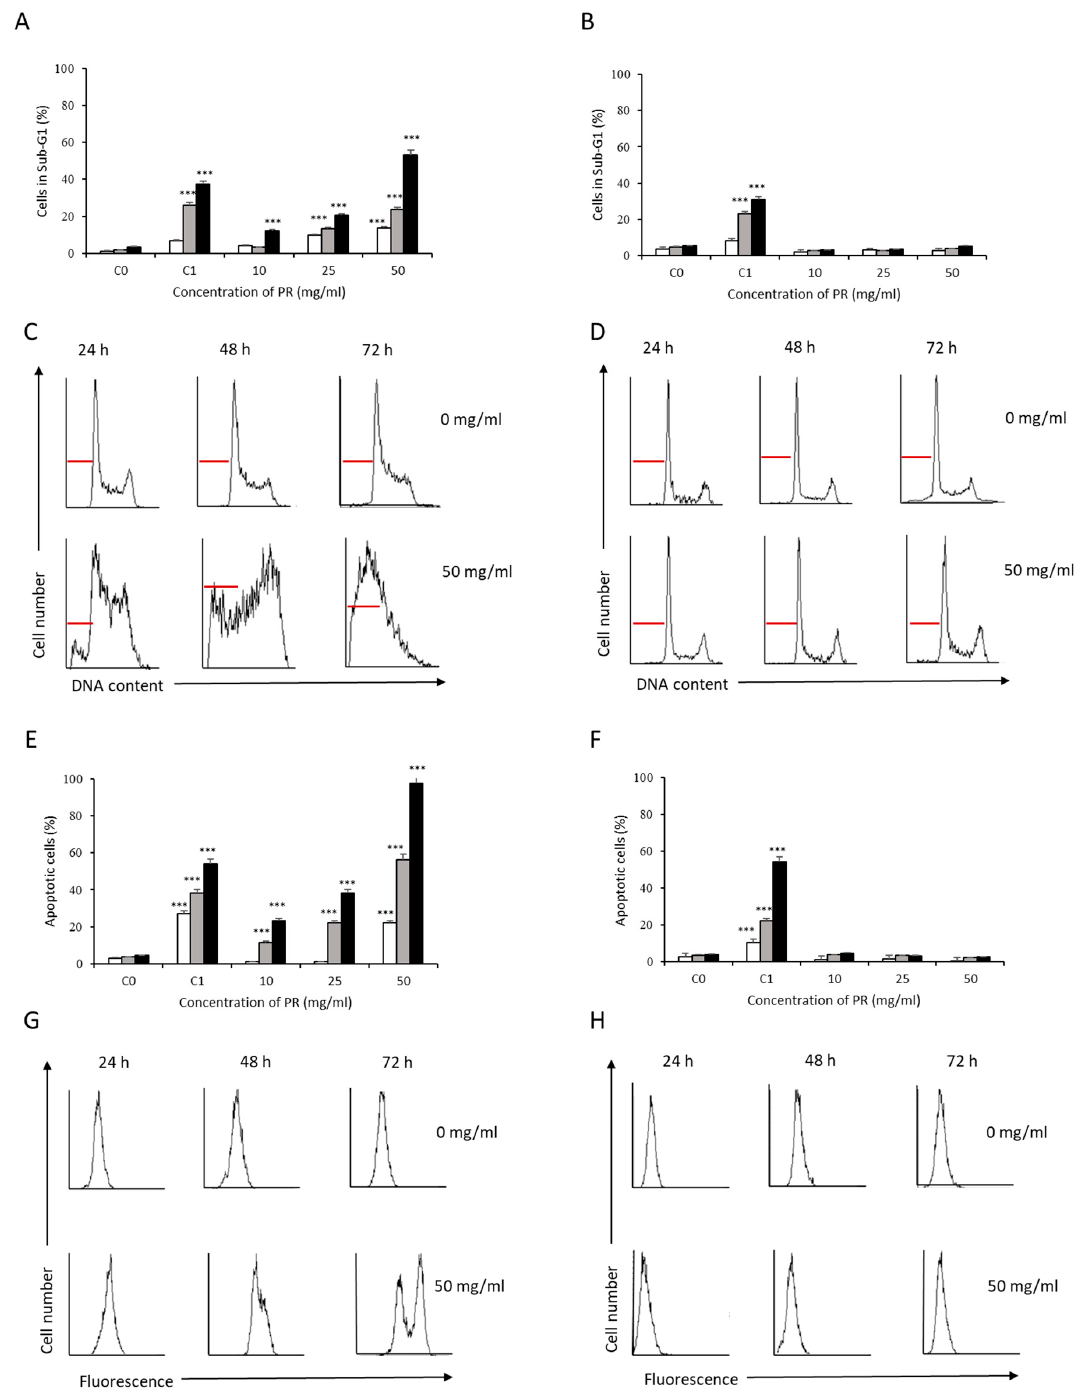
Figure 7. Effect of sample 16 (PR) on human liver cell apoptosis. The cell cycle was determined using flow cytometry. HepG2 ( A ) and WRL-68 ( B ) cells were treated with different doses of sample 16 (10, 25, and 50 mg/mL) for 24 ( □ ), 48 ( ■ ), and 72 h ( ■ ). Representative histograms of the cell cycle of HepG2 ( C ) and WRL-68 ( D ) cells are shown; the red line indicates the sub-G1 phase. The percentage of apoptosis was analyzed by flow cytometry using the TUNEL assay. HepG2 ( E ) and WRL-68 ( F ) cells were cultured with different doses of sample 16 (10, 25, and 50 mg/mL) for 24 ( □ ), 48 ( ■ ), and 72 h ( ■ ). Representative histograms of the fluorescence intensity in HepG2 ( G ) and WRL-68 ( H ) cells are presented. C 0 , untreated cells; C 1 , cells treated with etoposide (50 µM). Asterisks indicate a significant difference from the control (C 0 ). *** p ≤ 0.001.